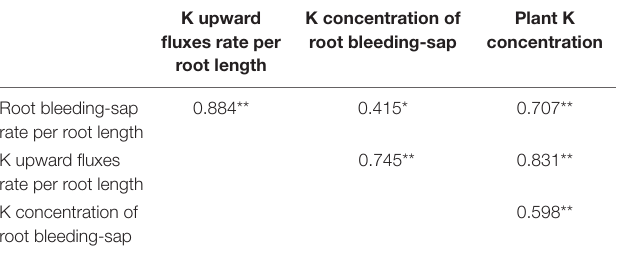
TABLE 2 | Correlation analysis of root bleeding-sap rate per root length, K upward fluxes rate per root length, K concentration of root bleeding-sap, and plant K concentration in vegetable soybean.